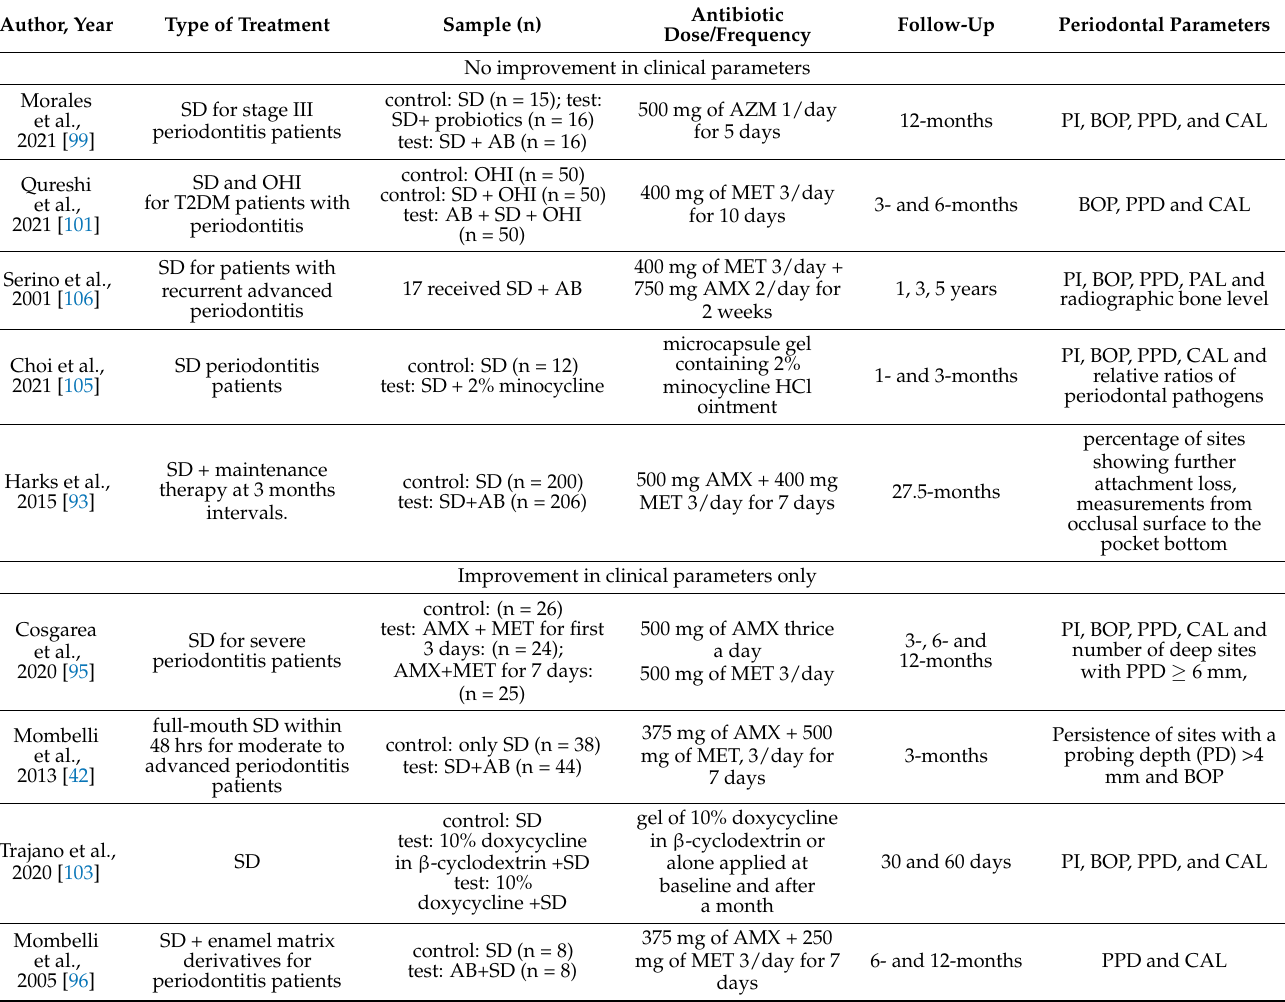
Table 3. Summary of randomized clinical trials on efficacy of antibiotics as adjunct to nonsurgical periodontal